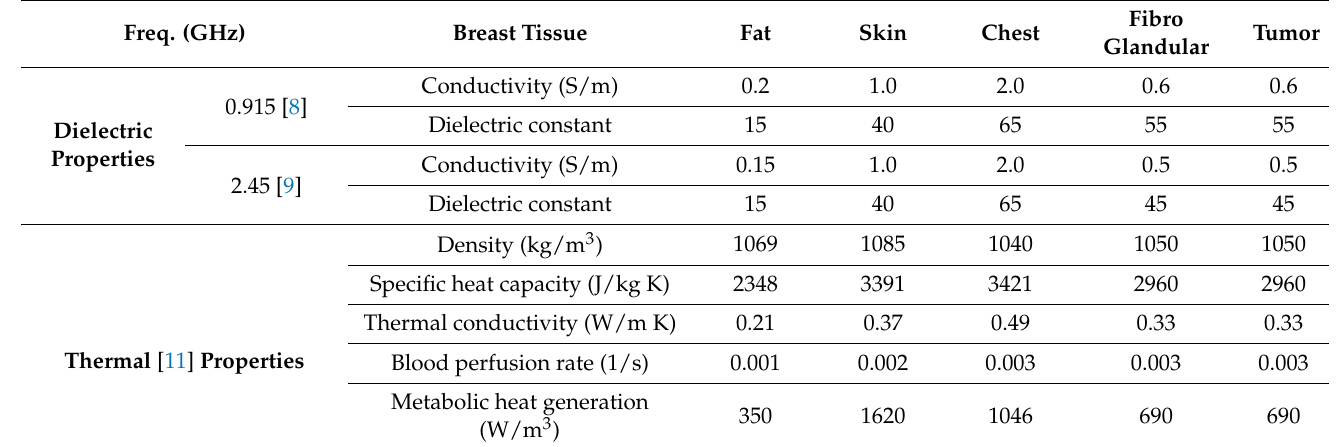
Table 1. Dielectric and thermal properties of breast tissue at 0.915 GHz and 2.45 GHz.